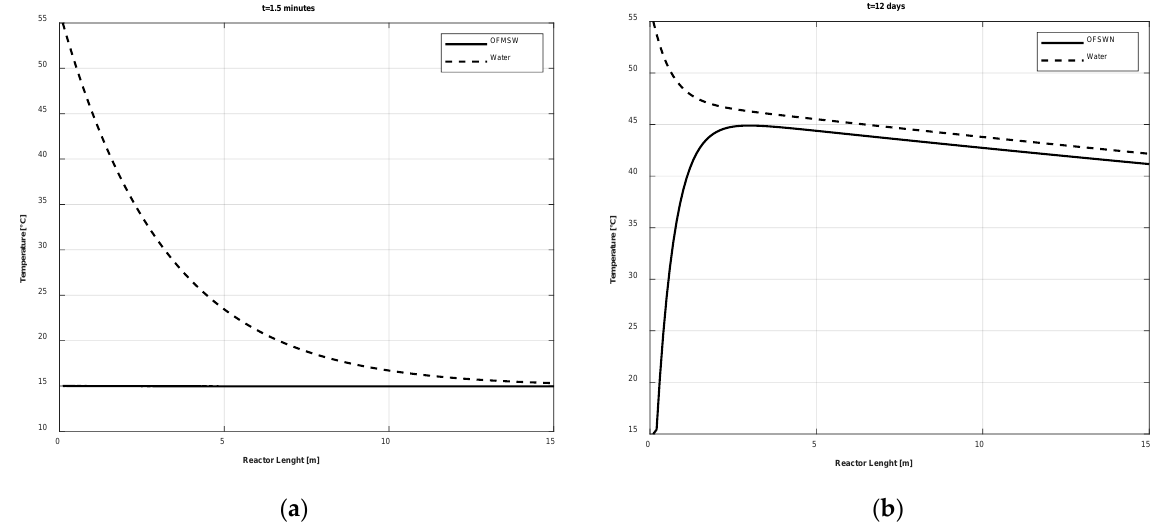
Figure 2. Output OFMSW and output water temperature at t = 1.5 min ( a ) and t = 12 days ( b ). The total flow rate of biogas is estimated assuming that the biogas mixture includes 65% of CH 4 and 35% of CO 2 . Figure 3 shows the trend of the concentration of the methane at the last slice of 1-D discretization of the PFR. The double exponential trend is due to two bacteria families responsible for the production of methane.